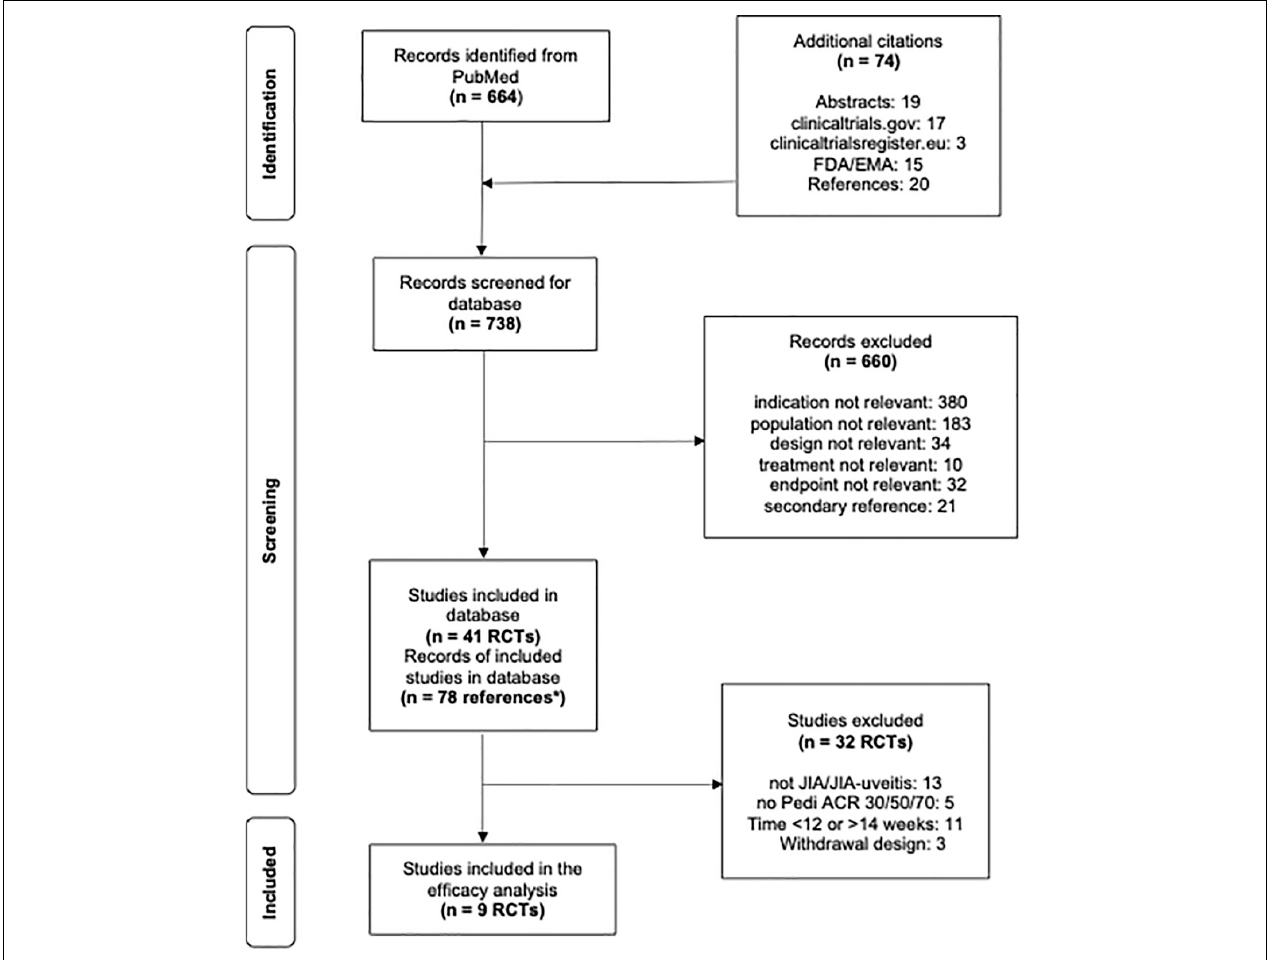
FIGURE 1 | Flowsheet literature review and study selection for analysis. * n = 78 Correspond to multiple references to a single study, i.e., more than one journal article, clinicaltrials.gov and/or regulatory